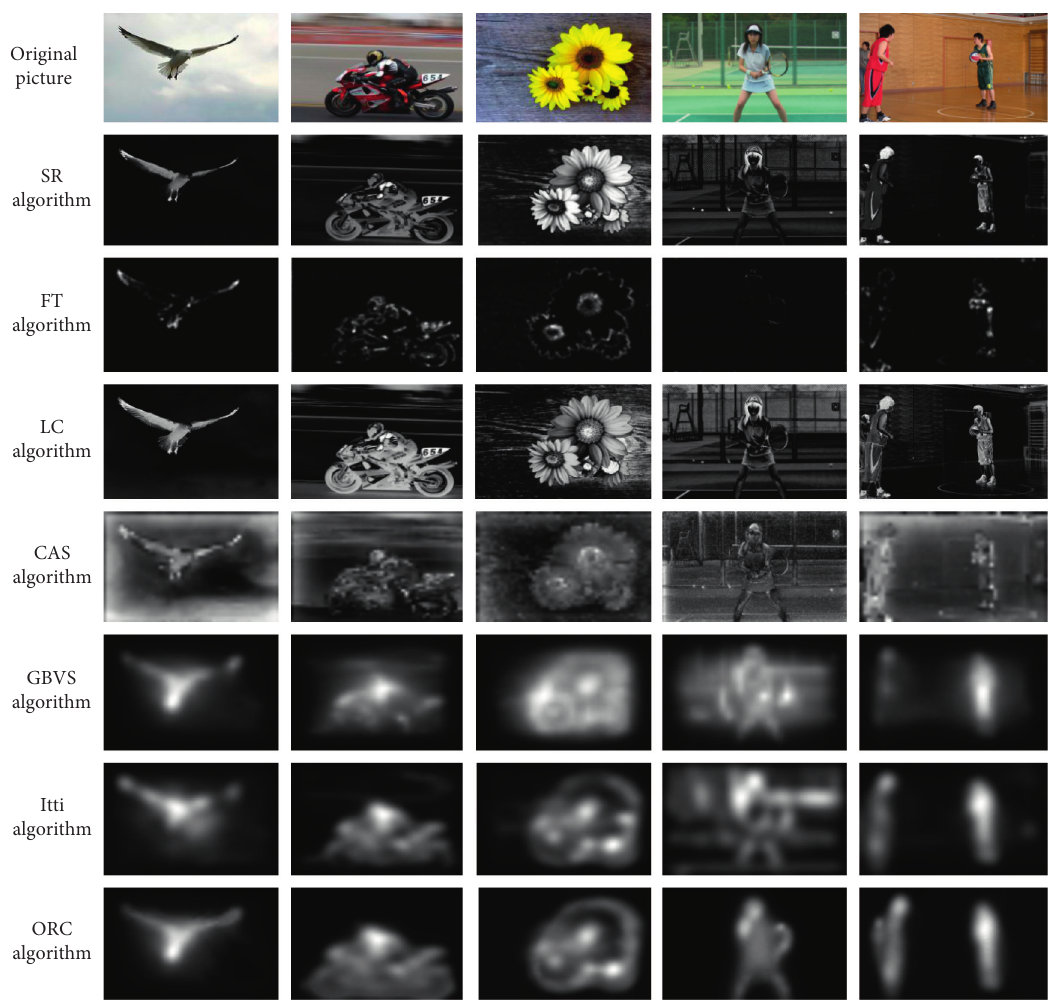
Figure 3: Experimental extraction results of ROI by seven